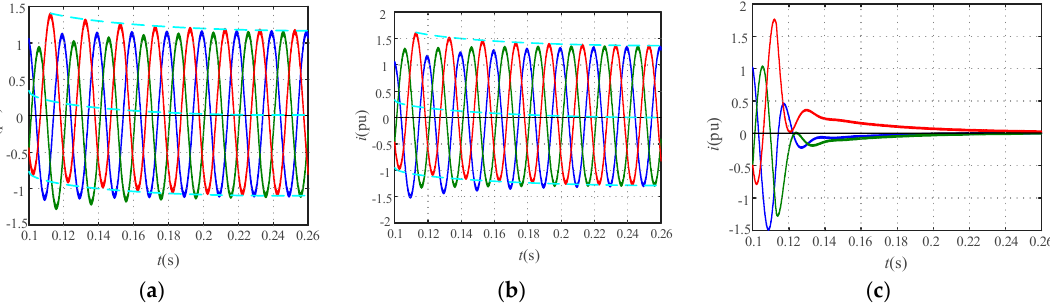
Figure 5. Measured three-phase short-circuit currents of a VSC-based renewable energy. ( a ) U ′ = 0.2 pu; ( b ) U ′ = 0.18 pu; ( c ) U ′ = 0.17 pu.